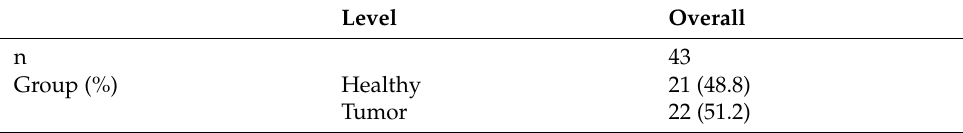
Table 3. Patients back ground for